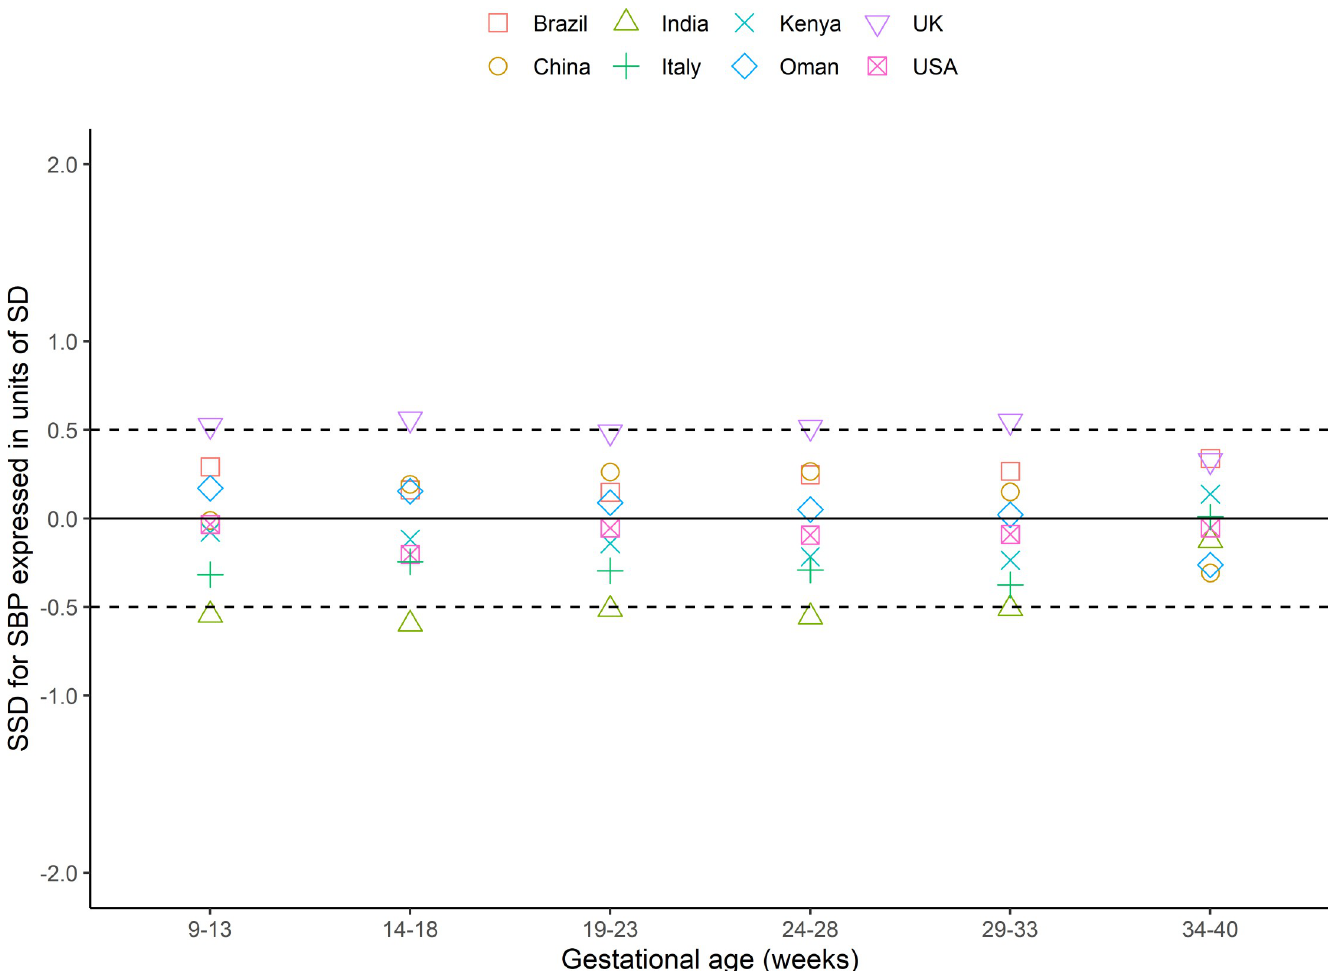
Fig 2. SSD for systolic blood pressure in the FGLS of the INTERGROWTH-21st Project. FGLS, Fetal Growth Longitudinal Study; SBP, systolic blood pressure; SD, standard deviation; SSD, standardised site difference.